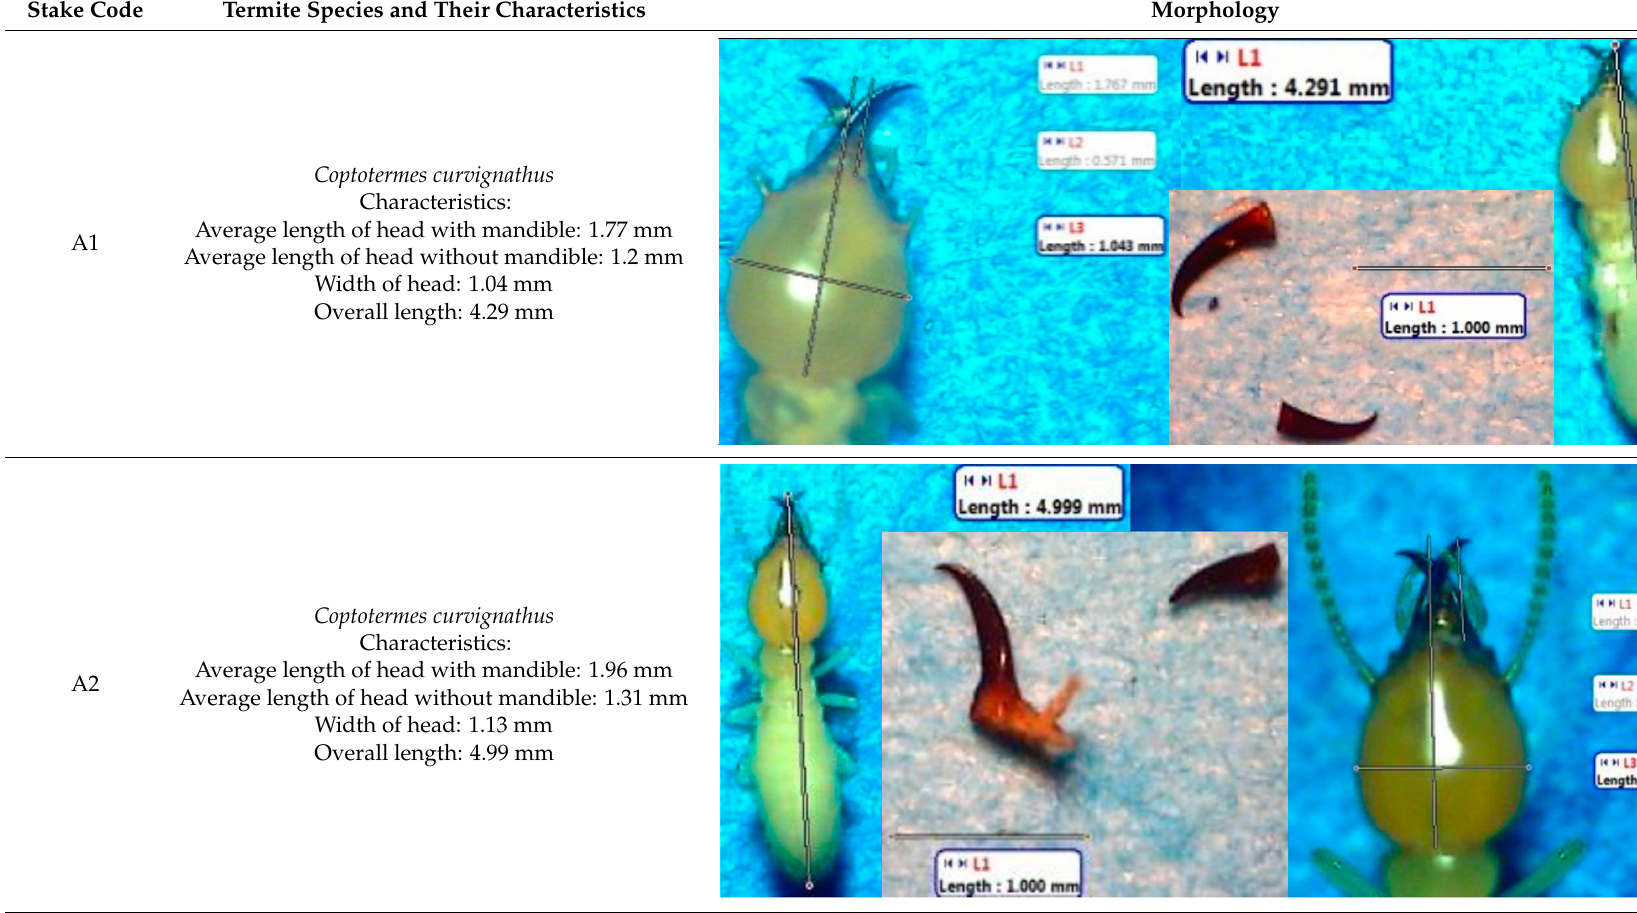
Table A1. The identification results of termites that attacked wood bait in South Jakarta.